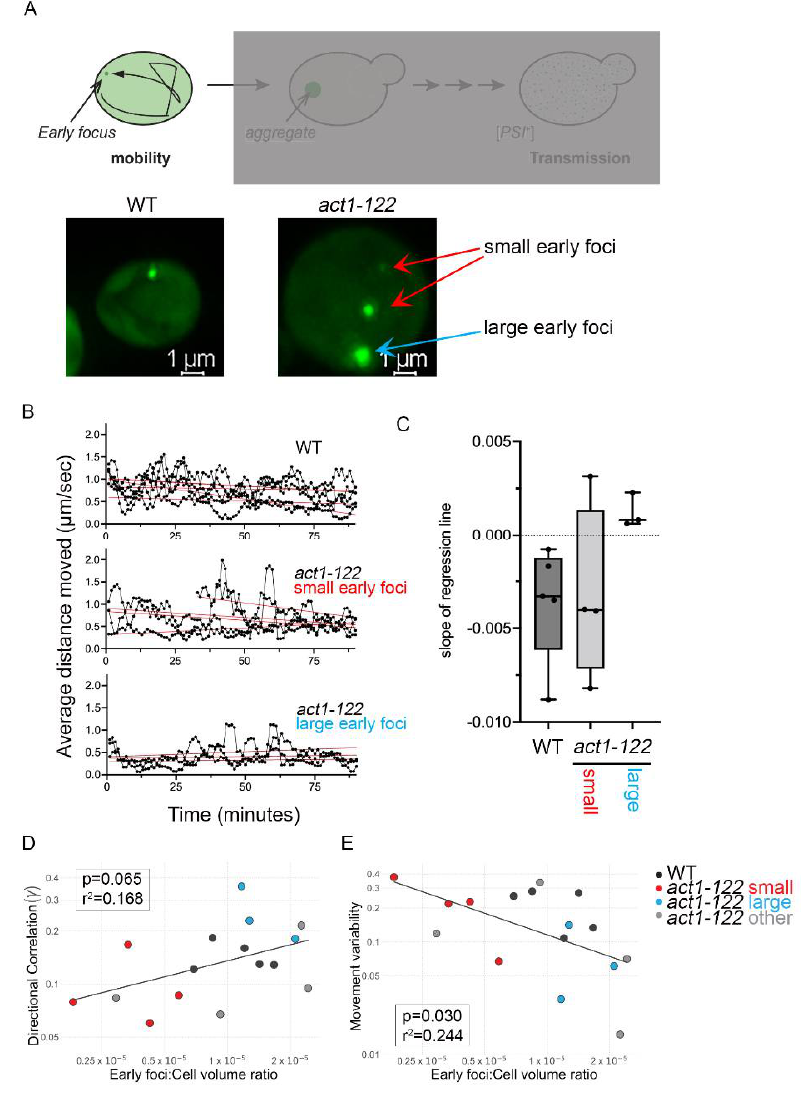
Figure 3. Small early foci in act1-122 strains are more mobile than large foci. ( A ) A representative image of a wildtype cell with one early focus versus a representative image of an act1-122 cell with multiple foci. Note that one early focus is larger than the rest in the act1-122 cell. ( B ) Using the 3D coordinates and distance moved per 10 s time interval presented in Figure 2, the simple moving average (SMA) speed of each early focus per 30 s (the average of speed taken between three subsequent frames) was plotted over time in wildtype cells ( top ). The SMA speed of small early foci ( middle ) or large early foci ( bottom ) from act1-122 strains were plotted over time. Red lines indicate the simple linear regression line of each individual early focus. A total of 11 early foci were tracked among the 6 act1-122 cells, but 4 such foci could not be cleanly categorized as small vs. large (Figure S4), so are not included within any of the plots of ( B ). However, they are included below in parts ( D , E ) of this figure as “other.” ( C ) The slope of the red regression lines in ( B ) for each early focus (wildtype, act1-122 small and large early foci) are displayed as box and whisker plots with median and interquartile ranges. Dots represent the slopes of foci regression lines indicated in ( B ). ( D ) Directional correlation measures randomness, with values above 0.5 indicating non-random movement. Directional correlation is plotted against early foci:cell volume ratio. ( E ) Movement variability is plotted against early foci:cell volume ratio. The colors indicate data points from specific foci categories. Dots in ( D , E ) correspond to each of the 16 early foci tracked in wildtype and act1-122 cells, and are color coded according to the legend at right ( E ), with "other” representing those foci in act1-122 cells that could not be cleanly categorized as small vs. large.